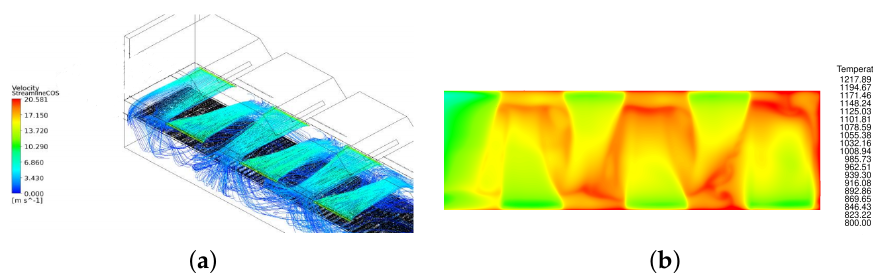
Figure 15. Iso-contours for: ( a ) velocity streamlines with cooling Scheme C; and ( b ) window temper- ature distribution for cooling Scheme